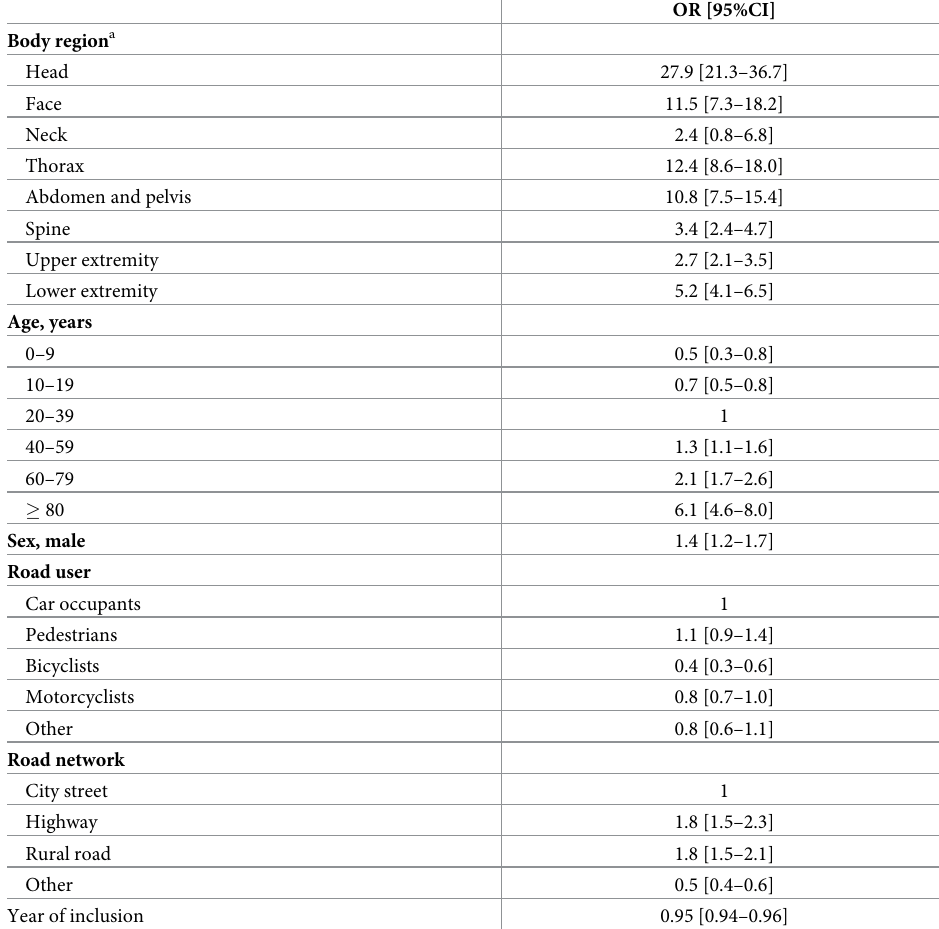
Table 4. Predictors of mortality in multivariate analysis in AIS � 2